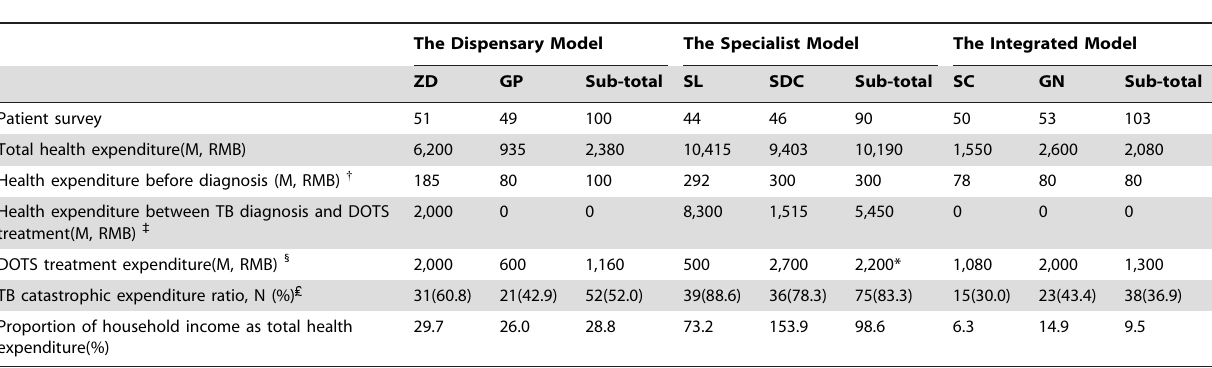
Table 4. Patient health expenditure for TB care in three